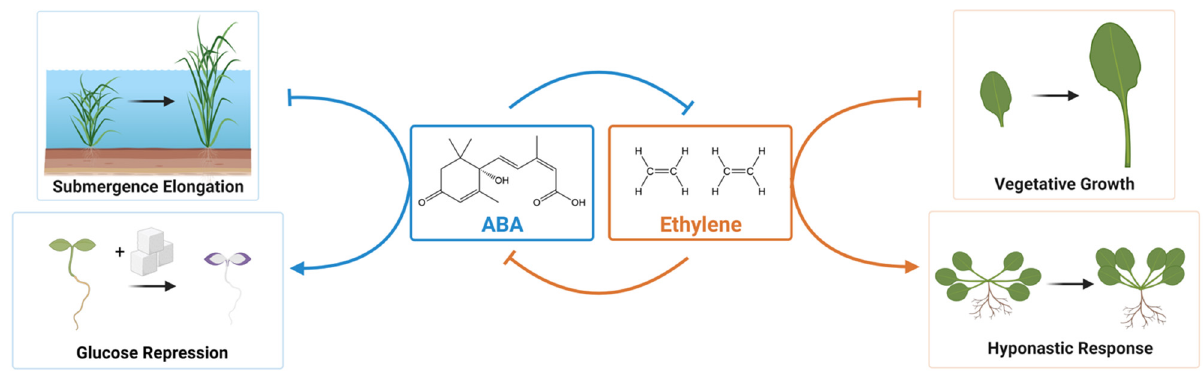
Figure 1. Regulation of plant growth by ABA and Ethylene antagonism. ABA and ethylene function in a mutually antagonistic way to regulate various aspects of plant growth. A prerequisite for shoot elongation in rice is ABA catabolism, which requires ethylene action. High concentrations of glucose are known to result in the growth arrest of Arabidopsis seedlings. This arrest depends on ABA synthesis and signaling and is antagonized by ethylene. Ethylene accumulation is thought to inhibit vegetative growth. One key role of basal ABA is to inhibit ethylene biosynthesis in growing plants. Ethylene signaling promotes hyponastic responses in Arabidopsis, which are antagonized by ABA. Figure created with BioRender (https://biorender.com/, accessed on 27 November 2021).